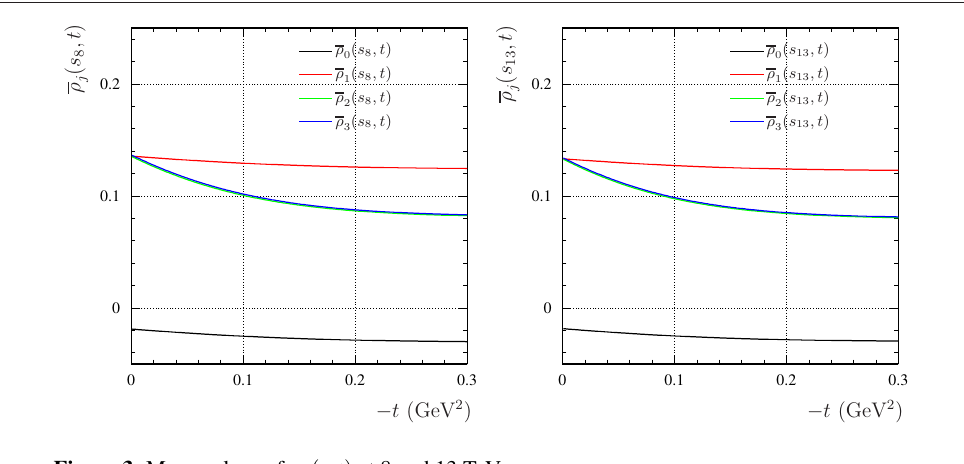
Figure 3. Mean values of ρ j ( s , t ) at 8 and 13